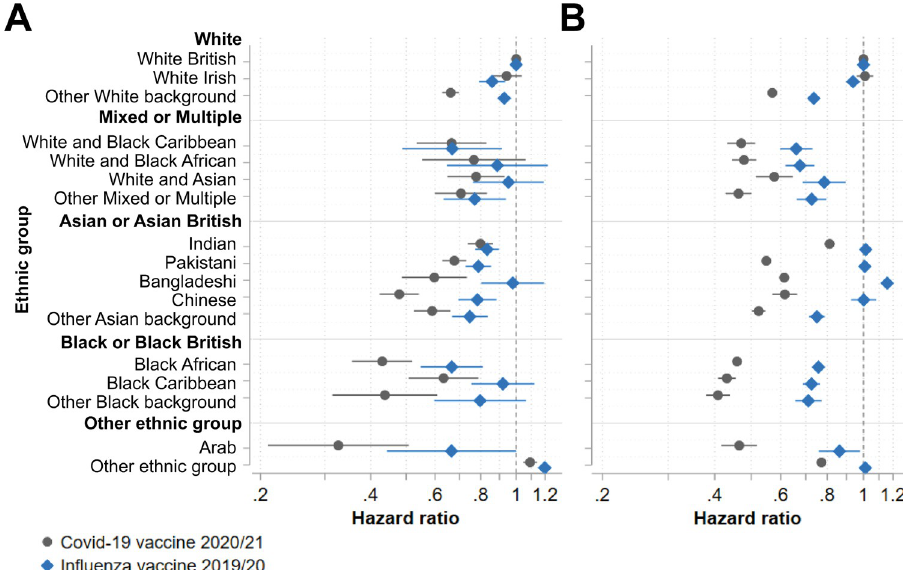
Fig 2. Associations between ethnic group and vaccine uptake by income deprivation. Hazard ratios with 95% confidence intervals from Cox proportional hazards models estimating time to vaccination across ethnic groups adjusted by vaccine eligibility group amongst individuals eligible for both the COVID-19 and 2019/2020 seasonal influenza vaccines living in (A) the 20% least income-deprived neighbourhoods and (B) the 20% most income- deprived